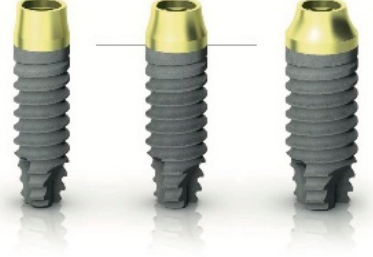
Figure 4. Reference point for marginal bone loss (MBL).